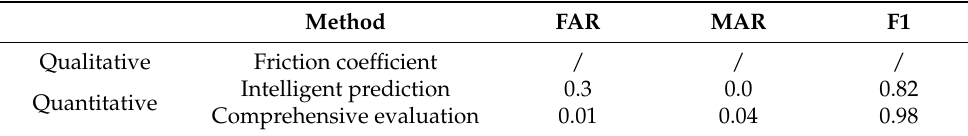
Table 3. Comparison of three prediction methods of stuck